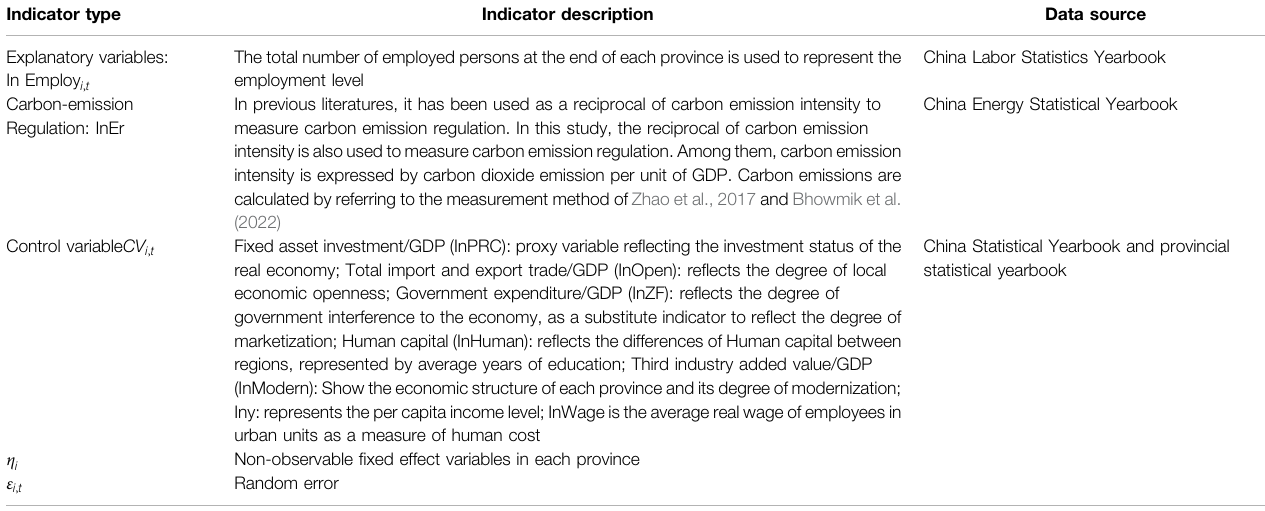
TABLE 1 | Variables involved in the model and their interpretation.